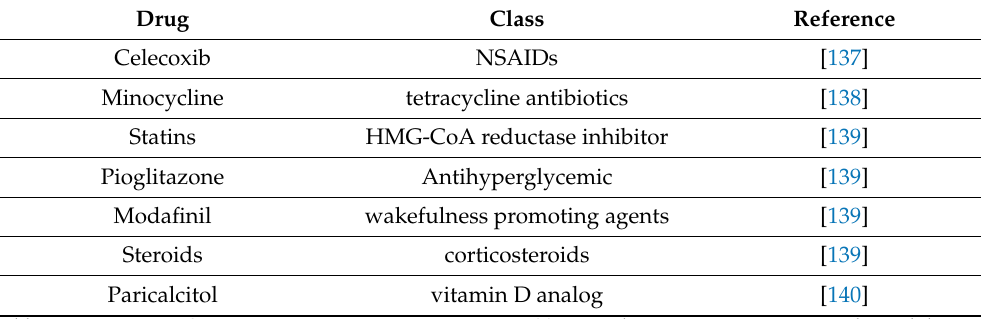
Table 1. Drugs targeting inflammation with potential for joint antidepressant